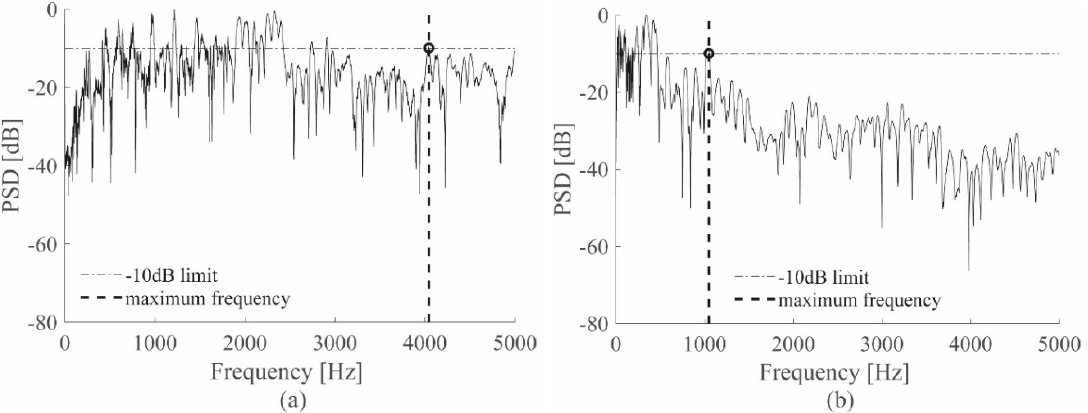
Figure 3. − 10 dB extraction procedure for ACC ( a ) and PZT ( b ) sensors.